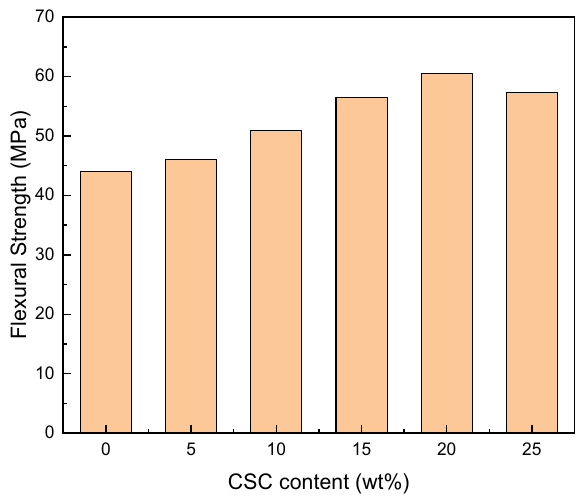
Figure 10. Flexural strength drawing of the composites.